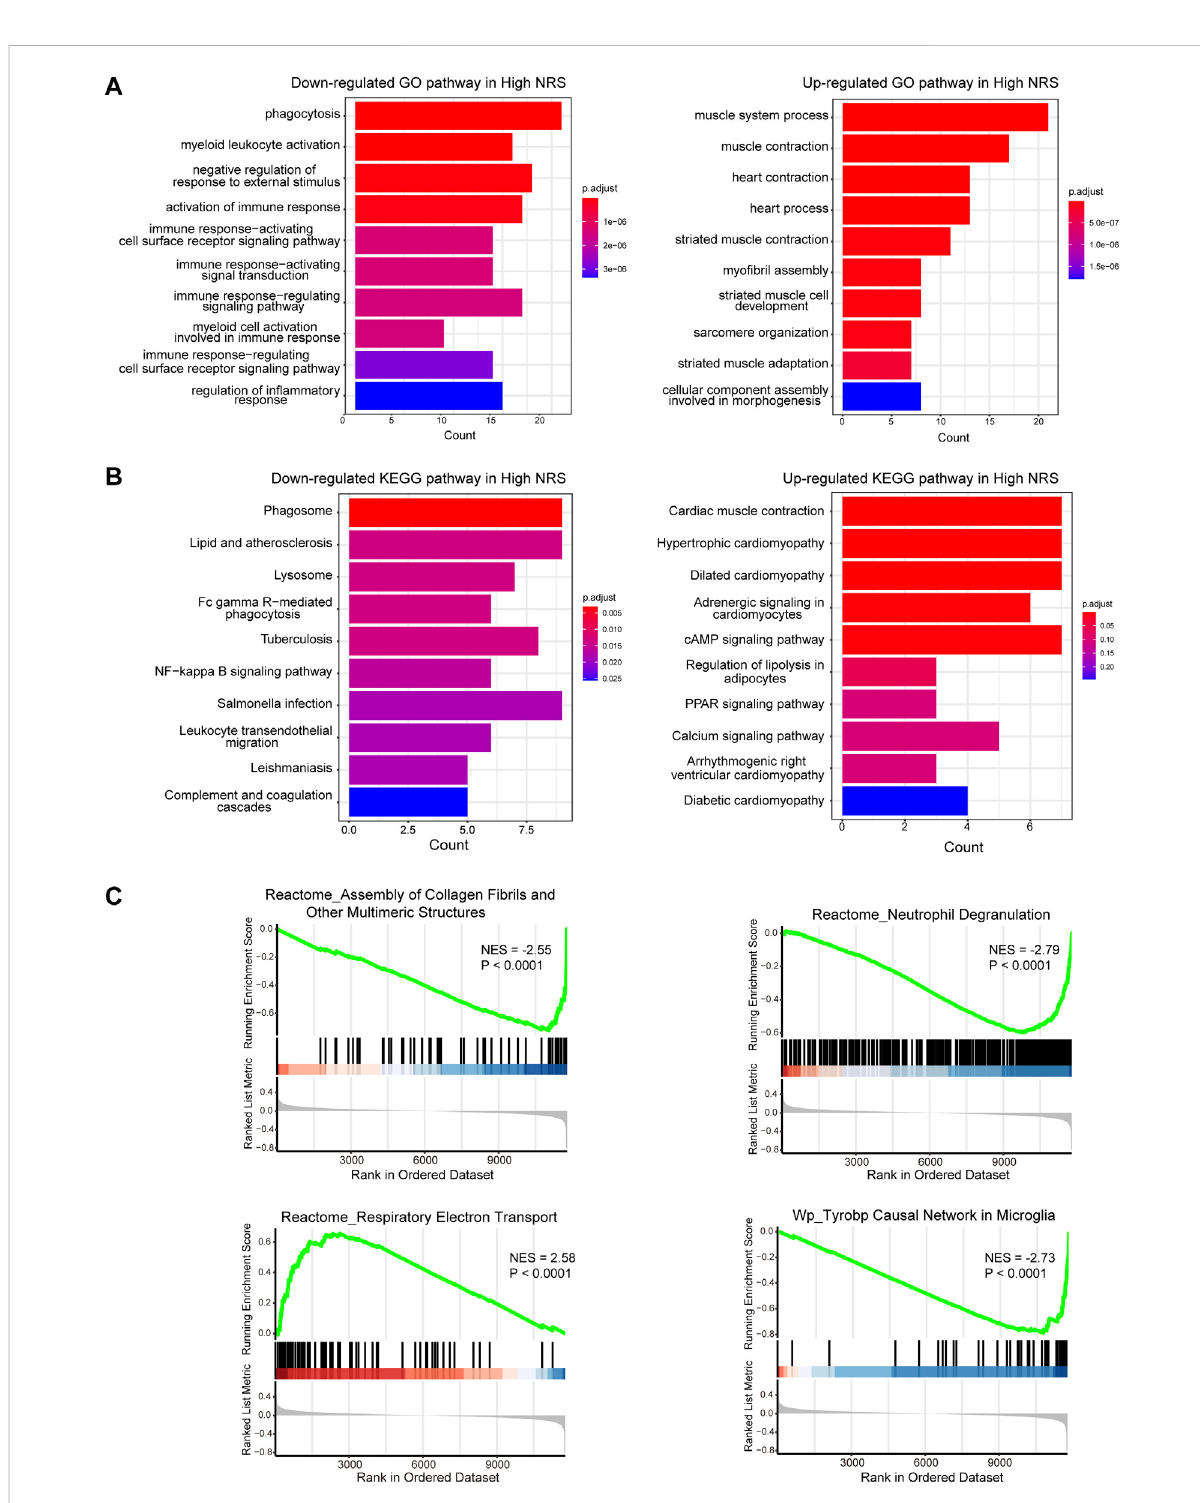
FIGURE 4 (A) GOfunctionalanalysisofgenesinhighNRS. (B) KEGGpathwayanalysisofgenesinhighNRS. (C) GSEAidenti fi essignalingpathwaysinvolved in high